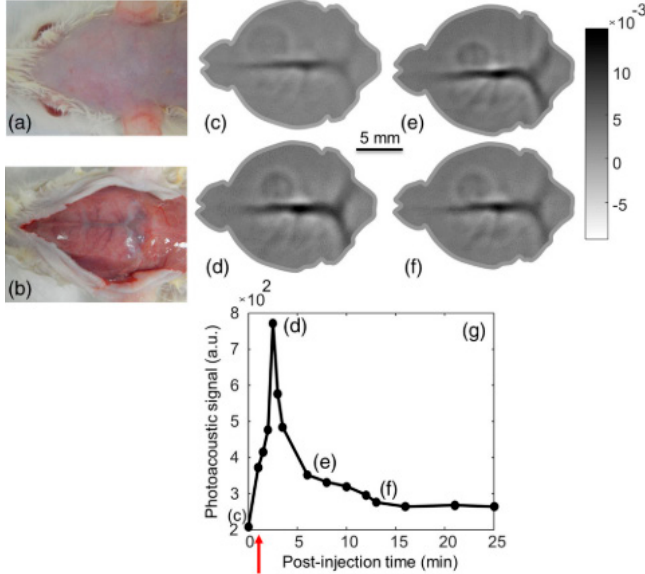
Figure 2. In vivo PLD-PAT brain imaging and pharmacokinetics of ICG intravenously injected in to rat brain: Photograph of rat brain before ( a ) and after ( b ) removing the scalp. In vivo brain images at different scan times ( c ) 0 s, ( d ) 2 min, ( e ) 6 min, and ( f ) 13 min. ( g ) Graph shows the quantification of ICG signal in the superior SS during 25 min following injection. The red arrow indicates the ICG injection point. Reproduced with permission from Ref. [30].